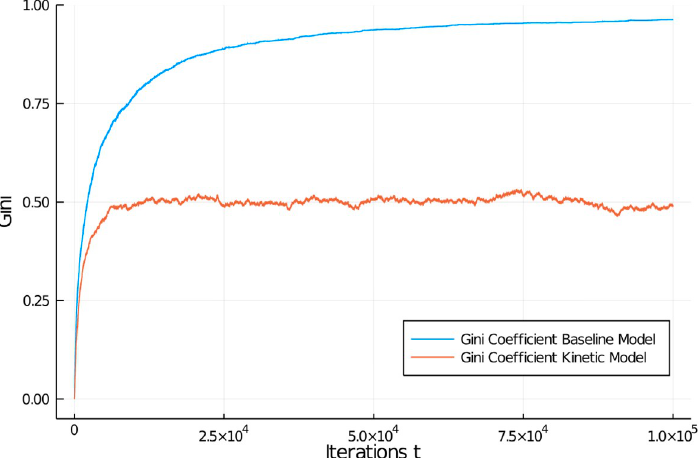
Fig 4. Comparison of Gini coefficients. Gini coefficients in population of 1,000 agents for the baseline economic and the kinetic exchange model. Initial distribution was equal among all 1,000 agents.